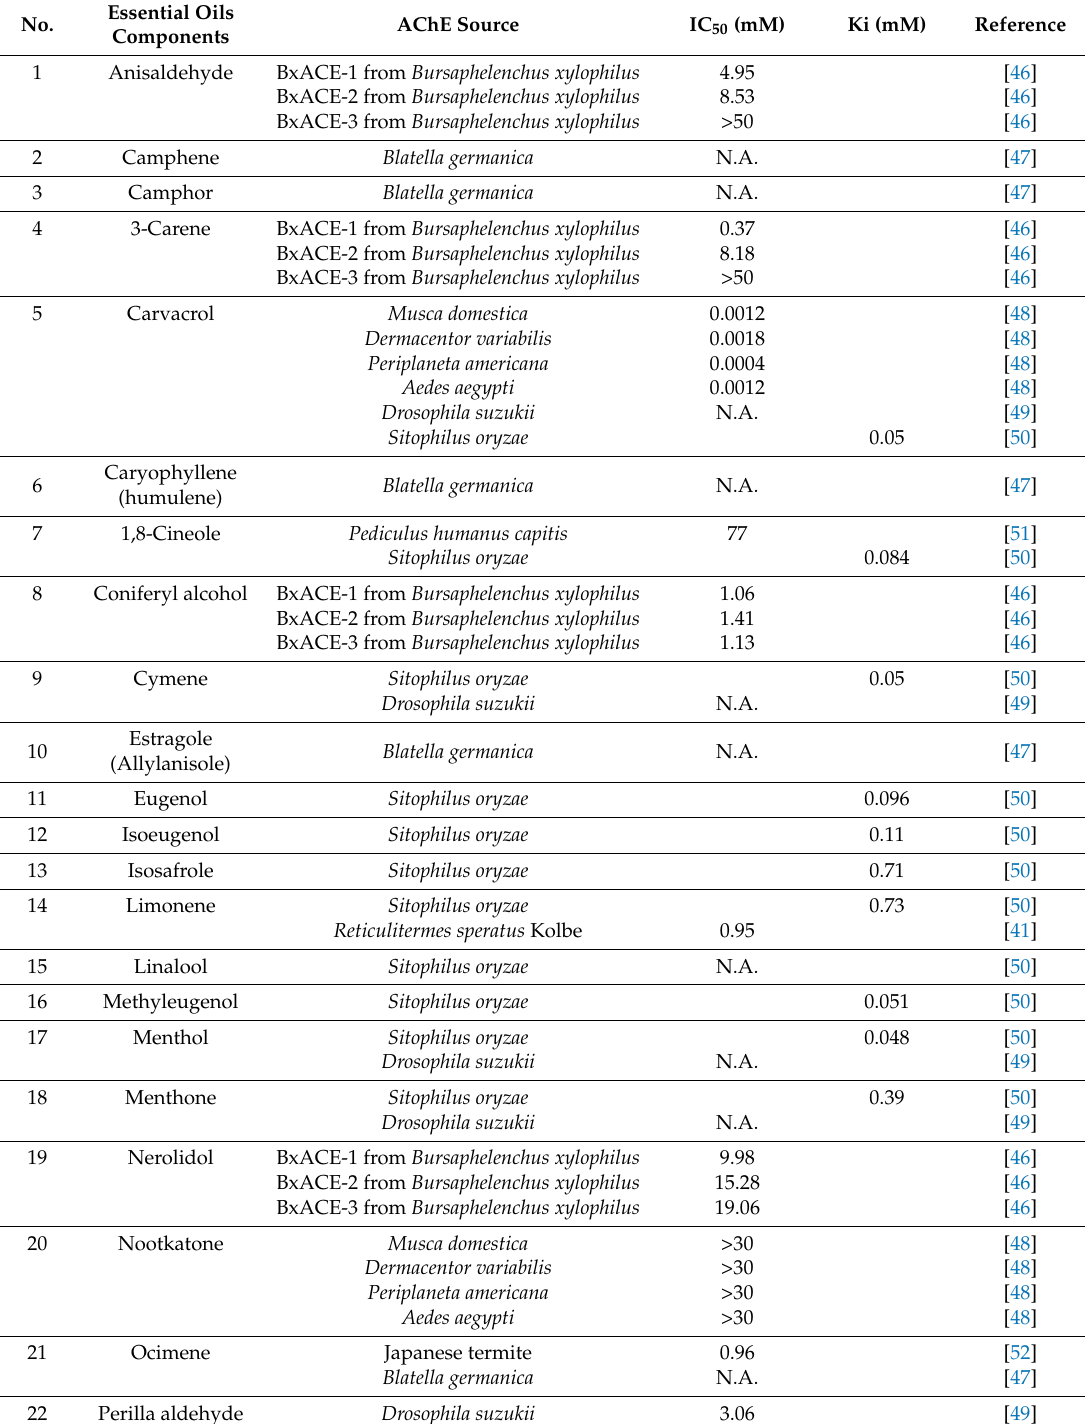
Table 1. The effects of the essential oil components on the acetylcholinesterase activity in insects.